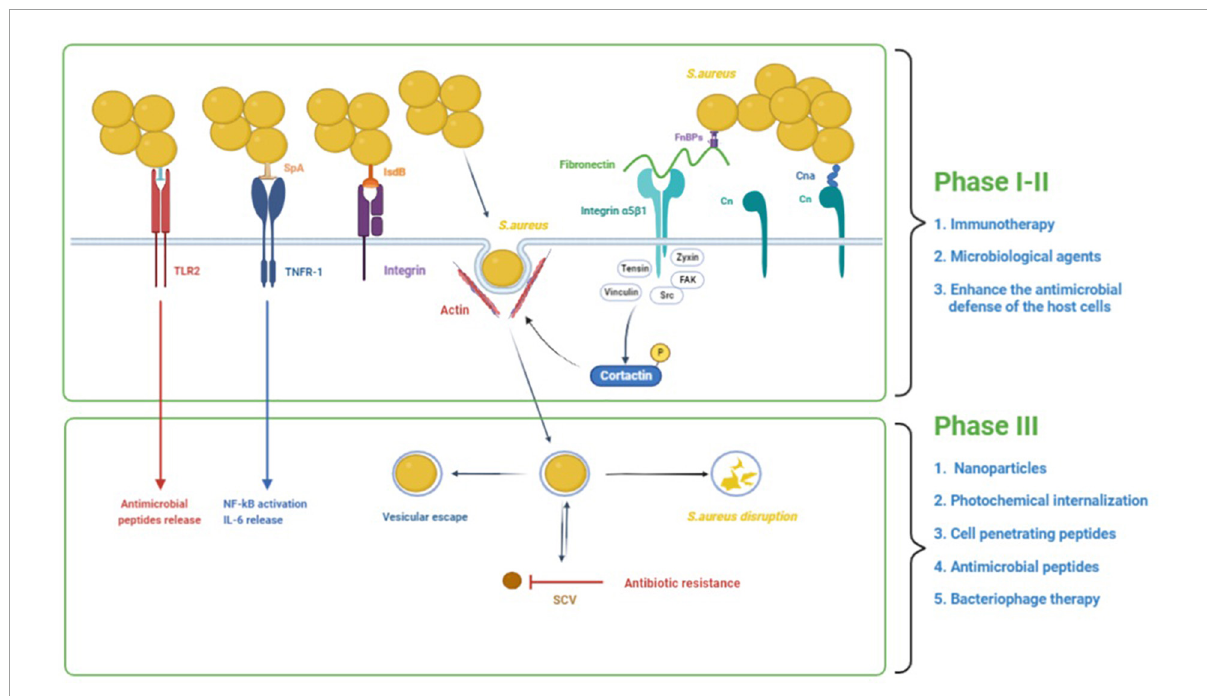
FIGURE1 The process of S. aureus internalization into cells and the potential treatments. The process of S. aureus internalization can essentially be divided into three phases: (1) S. aureus binds to the extracellular matrix (ECM), (2) fibronectin (Fn) receptors mediate S. aureus internalization into cells, and (3) intracellular S. aureus and persistence into osteoblasts. In addition to binding to the ECM, S. aureus can also directly stimulate osteoblasts through its PAMPs, resulting in a variety of cellular reactions. In the first and second phases, immunotherapy and some microbial agents can effectively interfere with bacterial adhesion. Besides, some agents could enhance the antimicrobial defense of the host cells by inducing the production of antimicrobial peptides and decreasing the secretion of inflammatory cytokines. In the third phase, some treatments such as nanoparticles, photochemical internalization, cell-penetrating peptides, antimicrobial peptides, and bacteriophage therapy have significant bactericidal effects against intracellular S. aureus